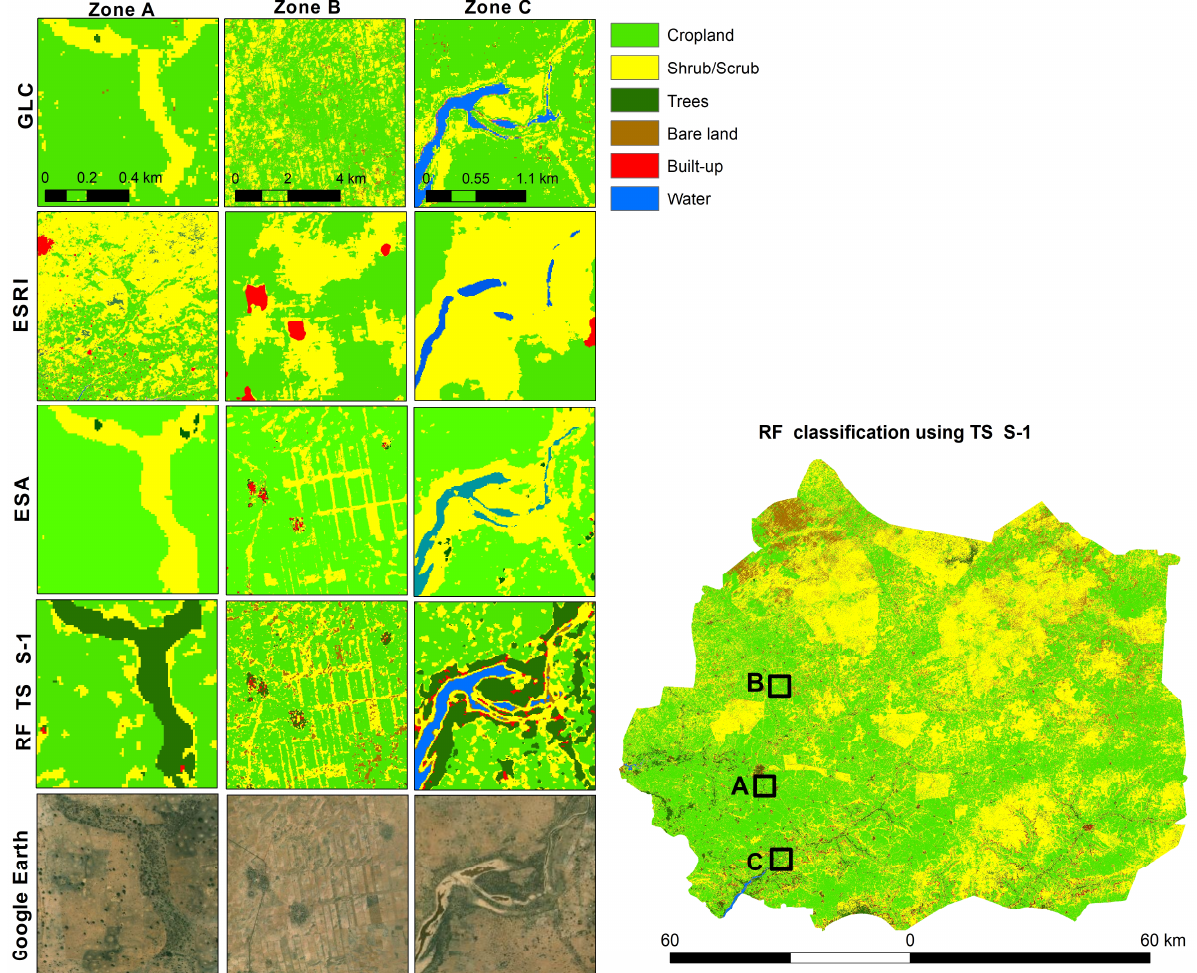
Figure 10. Detailed comparison between our RF50 land cover map with the ESRI, ESA, and FROM- GLC land cover maps over three local zones representing different agricultural landscapes within the Kaffrine region.